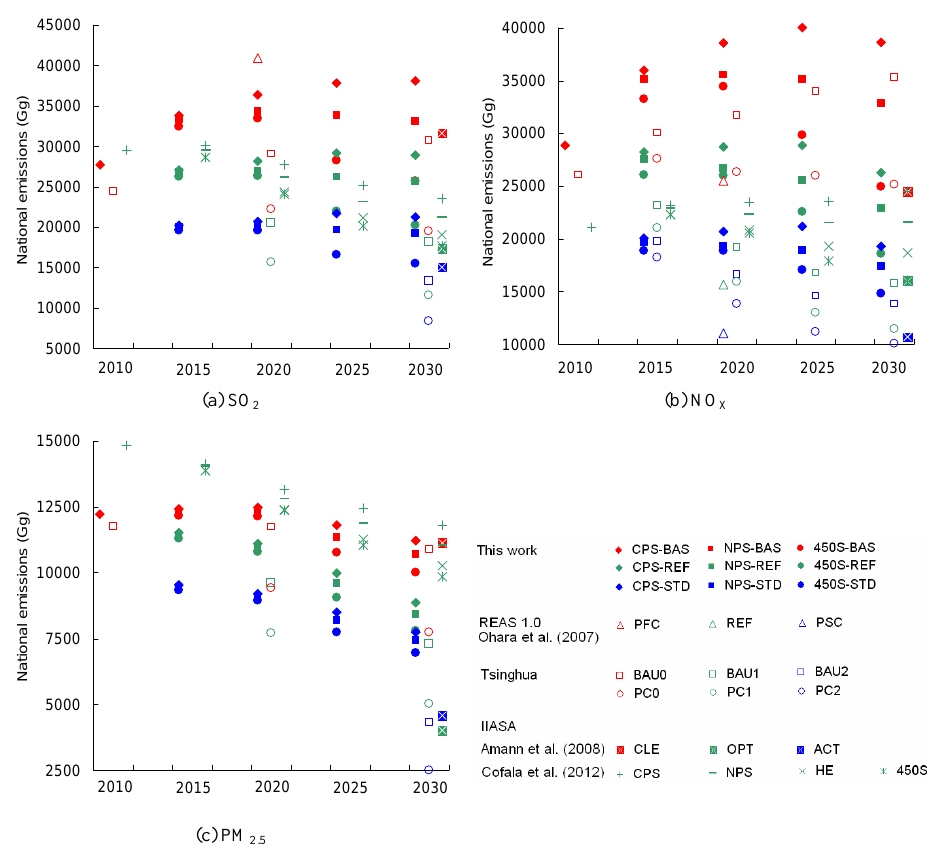
Figure 4. Comparisons of projected Chinese emissions between this work and other studies. (a) SO 2 , (b) NO x and (c) PM 2 . 5 .